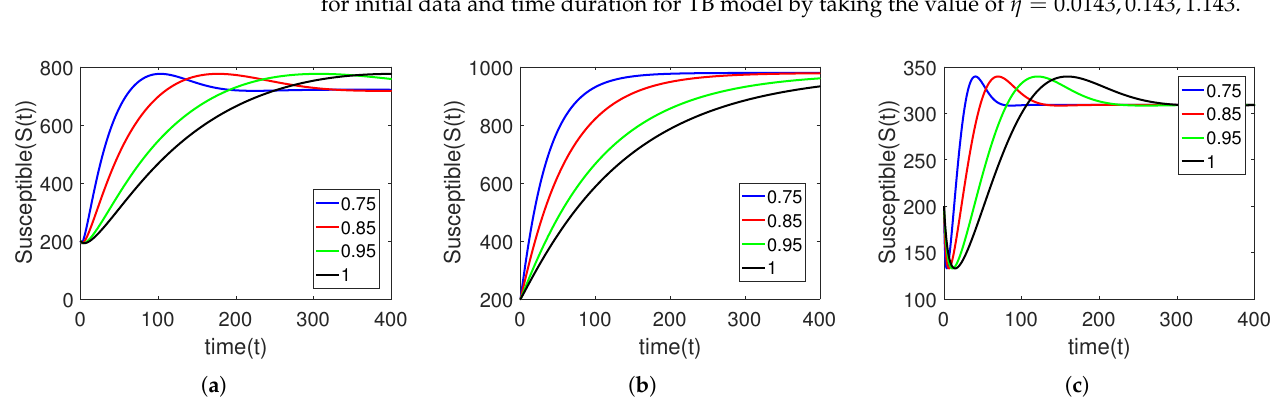
Figure 11. Graphical view ( a – c ) of Recovered class on different arbitrary orders γ = 0.75,0.85, 0.95,1 for initial data and time duration for TB model by taking the value of η = 0.0143,0.143,1.143.